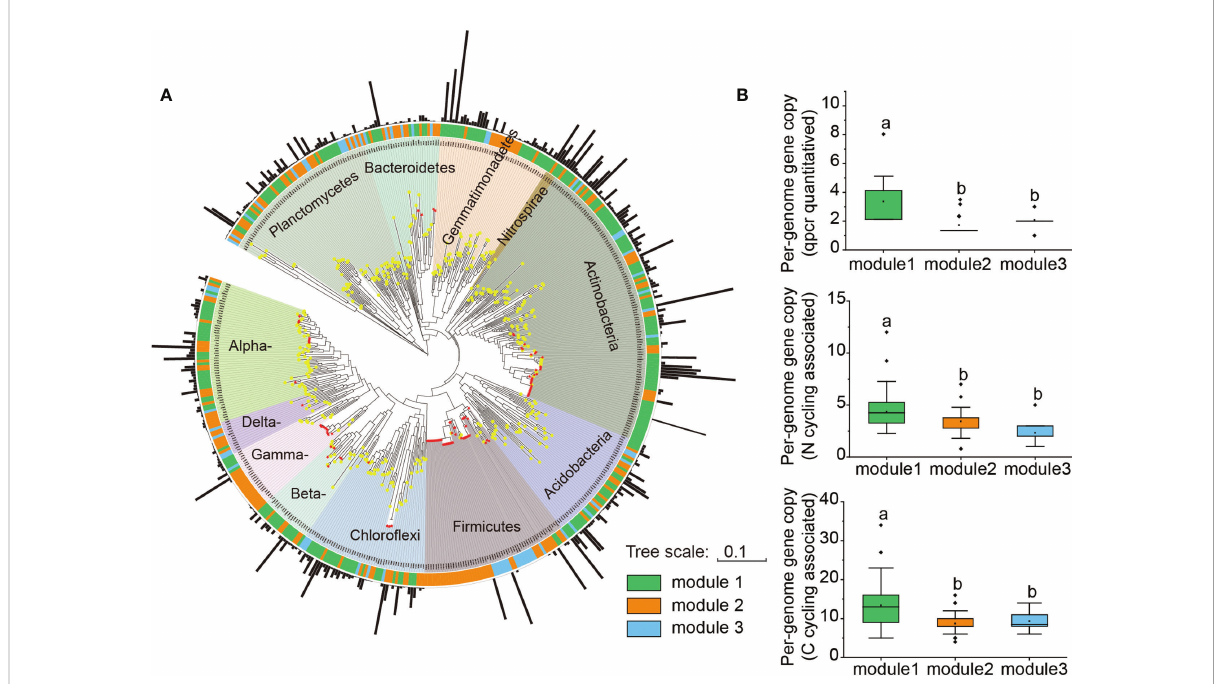
FIGURE 4 Phylogenetic properties and per-genome gene copies of mapped taxa from different modules. (A) Phylogenetic tree of dominant OTUs from Modules, and 35 whole genomes (with >97% identity across the sequenced region of the 16S rRNA gene) downloaded from the JGI-IMG websites (https://img.jgi.doe.gov/). Black bar: relative abundance of each OTU. Red star on the tree: ssu rRNA 16S marker genes of the whole genomes. (B) The normalized per-genome copy numbers of eight tested genes, and other reference genes associated with carbon (18) and nitrogen (14). The normalized copy numbers are shown as the percentage (%) of genes per genome. The diamond symbol in each box plot represents the mean value.